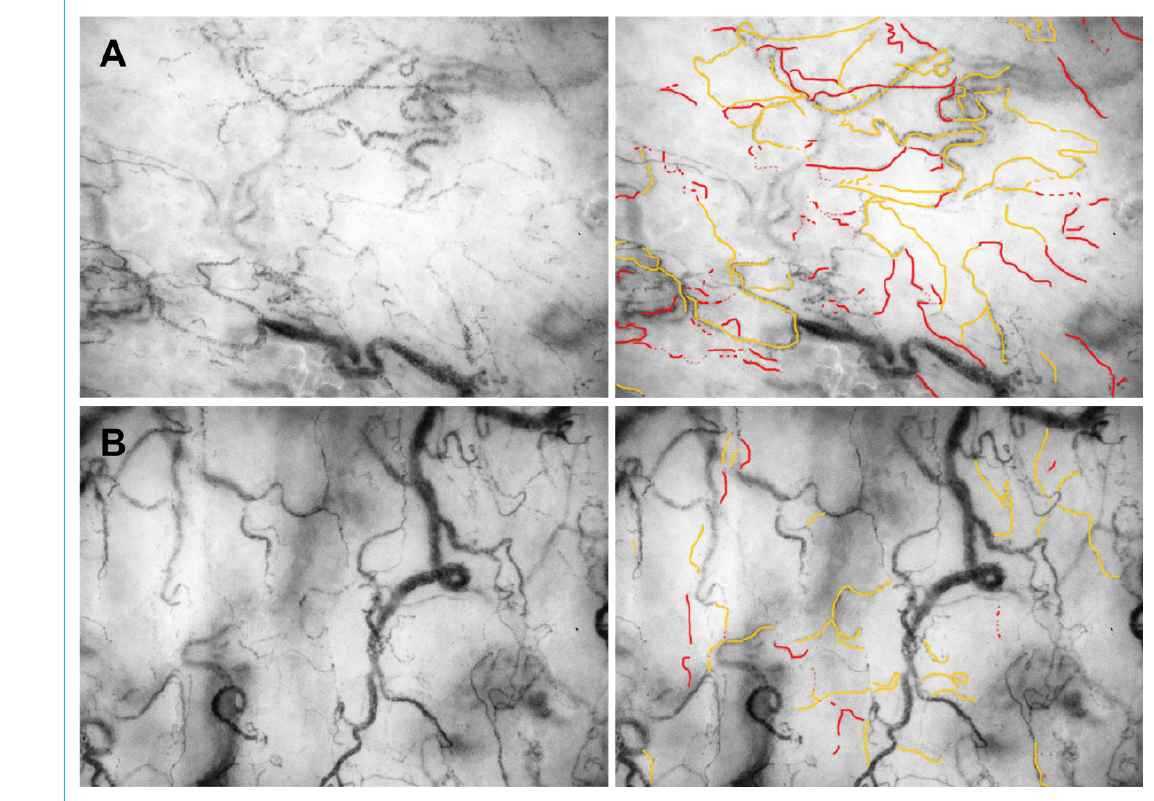
Figure 2: Influence of fluid resuscitation on the sublingual microcirculation. Panel A shows the microcirculation of a patient in haemorrhagic shock. Most of the visible microvessels show are intermittently perfused (orange lines) or show no flow (red lines). Panel B shows the microcir- culation of the same patient after resuscitation with on unit packed red cells. The amount of microvessels with intermittent flow differs marked- ly. Only very view vessel parts show a no flow